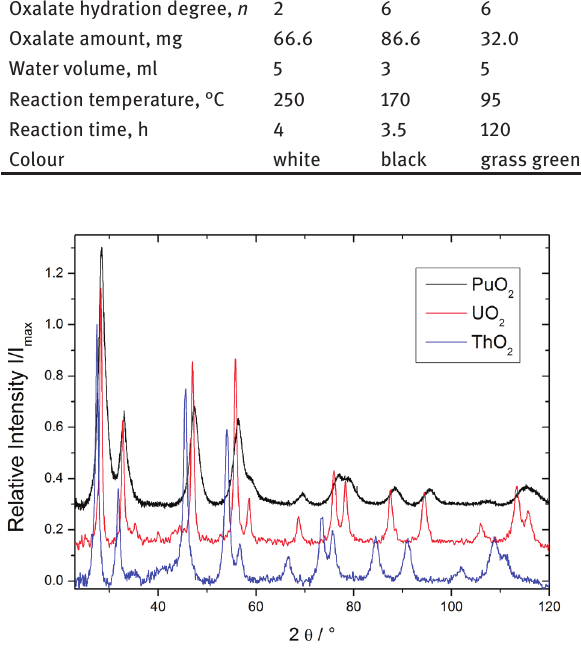
obtained by 2 , UO , and PuO 2 2 2